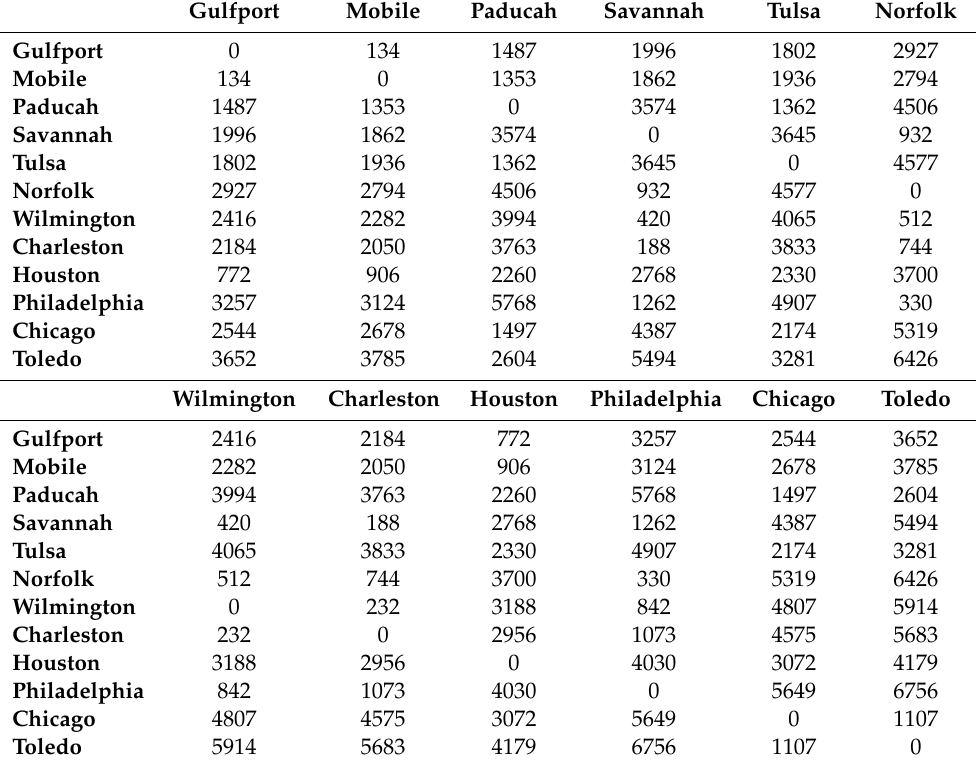
Table A10. Barge distances between Extraction and Transesterification locations